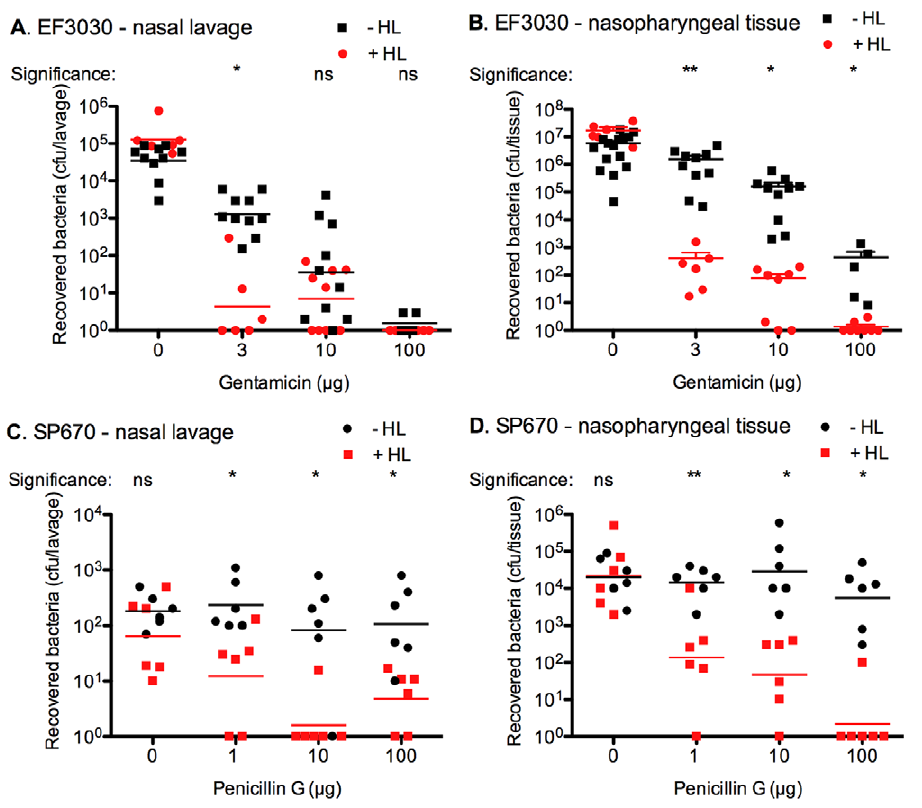
Figure 4. HAMLET-antibiotic combination treatment eradicates pneumococci during nasopharyngeal colonization. (A and B) Mice were colonized with S. pneumoniae EF3030 for 48 hours, treated intranasally with various doses of gentamicin in the presence (red circles) or absence (black squares) of HAMLET (50 m g) for 6 hours, and the bacterial burden associated with the nasal lavage (A) and the nasopharyngeal tissue (B) was determined. Bacteria in nasal lavage and associated with the nasopharyngeal tissue were significantly more sensitive to gentamicin/HAMLET combination therapy than gentamicin alone. (C and D) Mice were colonized with the penicillin-resistant strain S. pneumoniae SP670 (MIC =4 m g/mL) for 48 hours, treated intranasally with various doses of penicillin G in the presence (red circles) or absence (black squares) of HAMLET (50 m g) for 12 hours and the bacterial burden associated with the nasal lavage (C) and the nasopharyngeal tissue (D) was determined. Penicillin G alone had no effect on the bacterial burden in either the nasal lavage or in the tissue. However, combination therapy with HAMLET and penicillin caused a dose- dependent decrease in bacterial burden leading to eradication of colonization. The graph shows colonization data for individual mice, with the mean recovered bacteria and the standard deviation depicted. The results are based on experiments using groups of 6–10 mice. Statistics was performed using the unpaired Student t-test. Significance was indicated as follows: *= P , 0.05, **= P , 0.01, ns = non-significant.